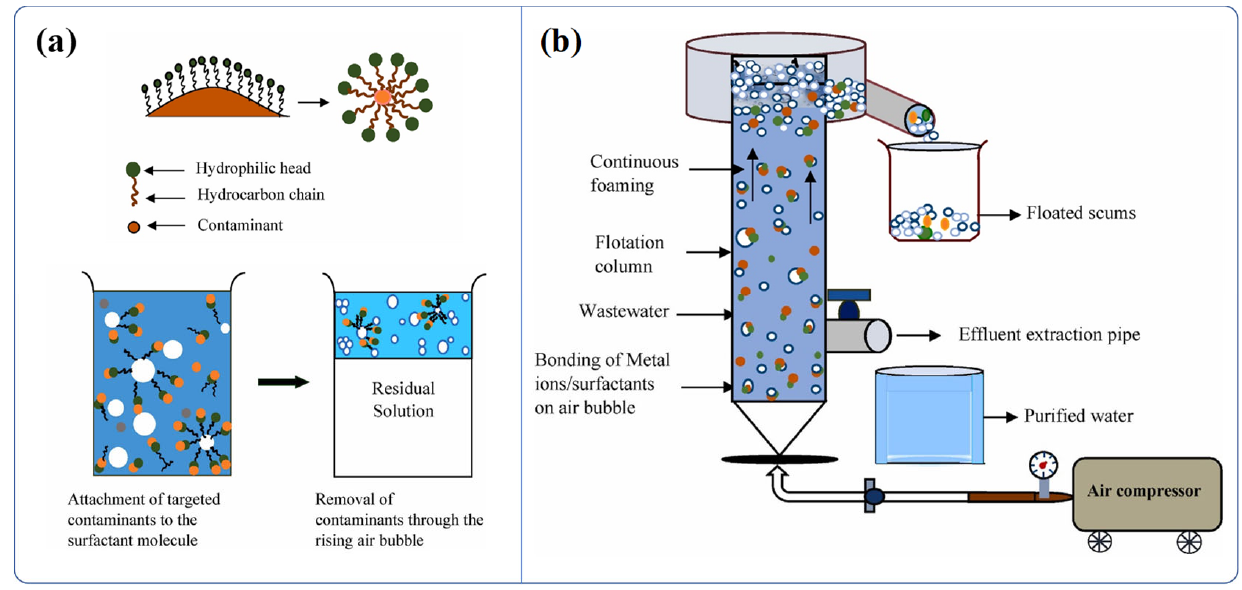
Figure 16. ( a ) Interaction mechanism of agents and ions; ( b ) Schematic diagram of flotation system, reproduced from [147], with permission from Elsevier, 2022.